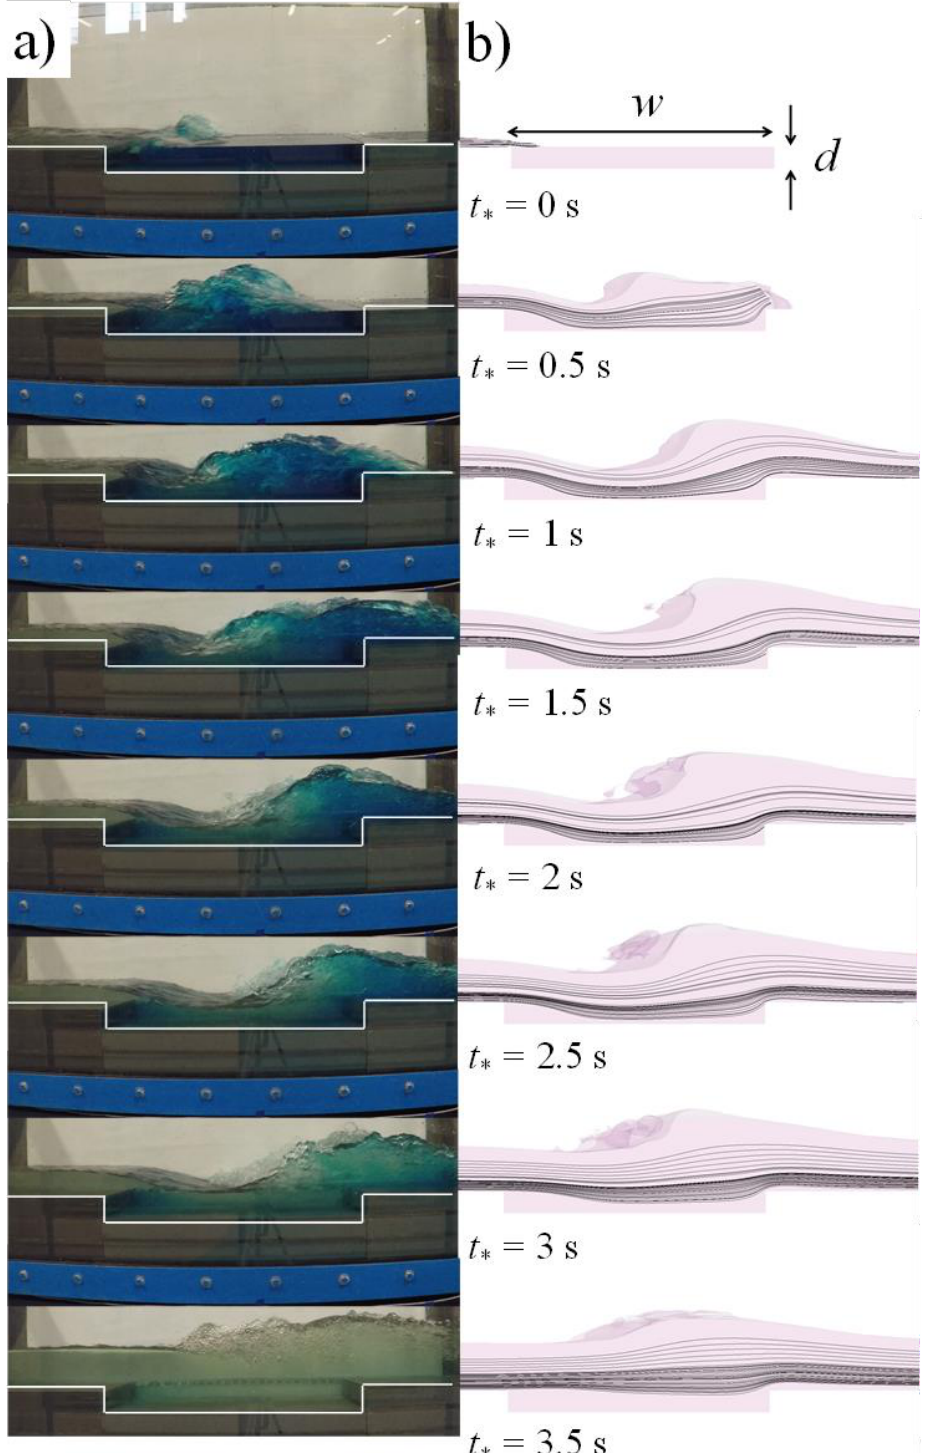
Figure 7. Time history of water surface profiles of a bore from an impoundment with a depth of d o = 0.3 m, passing over a canal with a width of w = 0.6 m and a depth of d = 0.05 m: ( a ) side-view images; ( b ) simulated water surface profile and streamlines.